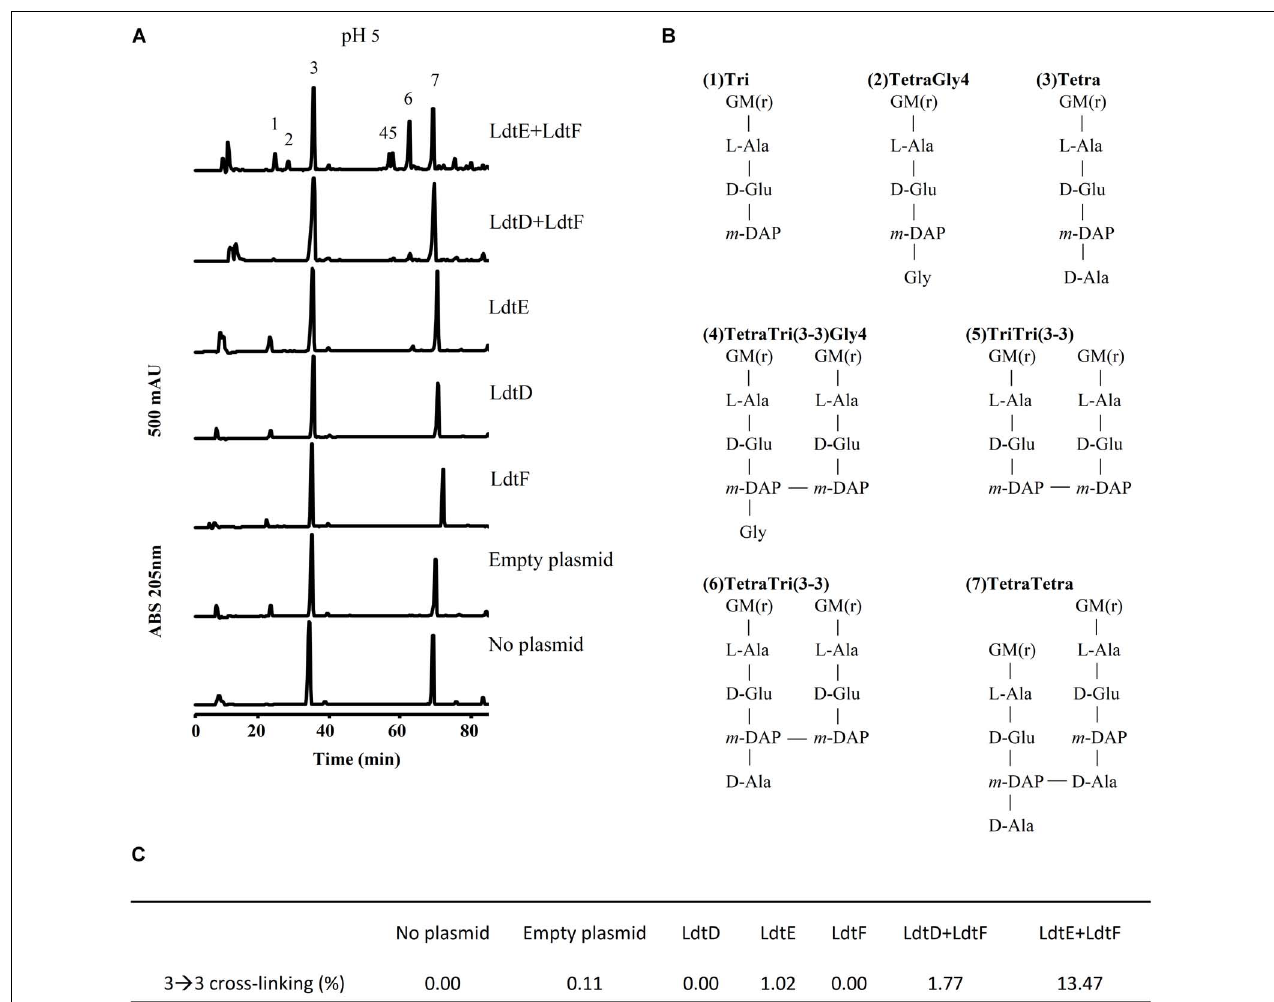
FIGURE 3 | LD-TPase-mediated formation of 3–3 cross-links in cells growing at acidic pH. (A) Muropeptide profiles of BW25113 (cid:49) 6LDT cells containing either no plasmid, control plasmid pSAV057, or plasmid for expression of ldtD , ldtE , ldtF , ldtE and ldtF , or ldtD and ldtF , grown in the presence of 50 µ M IPTG at pH 5.0. (B) Structures of major muropeptides numbered in the top chromatogram in panel A . LD-TPase products are muropeptides containing 3–3 cross-links (No. 4–6), tripeptides (peaks 1 and 5), and glycine at position 4 (Gly4, No. 2 and 4). G, N -acetylglucosamine; M(r), N -acetylmuramitol; L -Ala, L -alanine; D -Glu, D -glutamic acid; D -Ala, D -alanine; meso -DAP, meso-diaminopimelic acid. (C) Relative amount (%) of muropeptides with 3–3